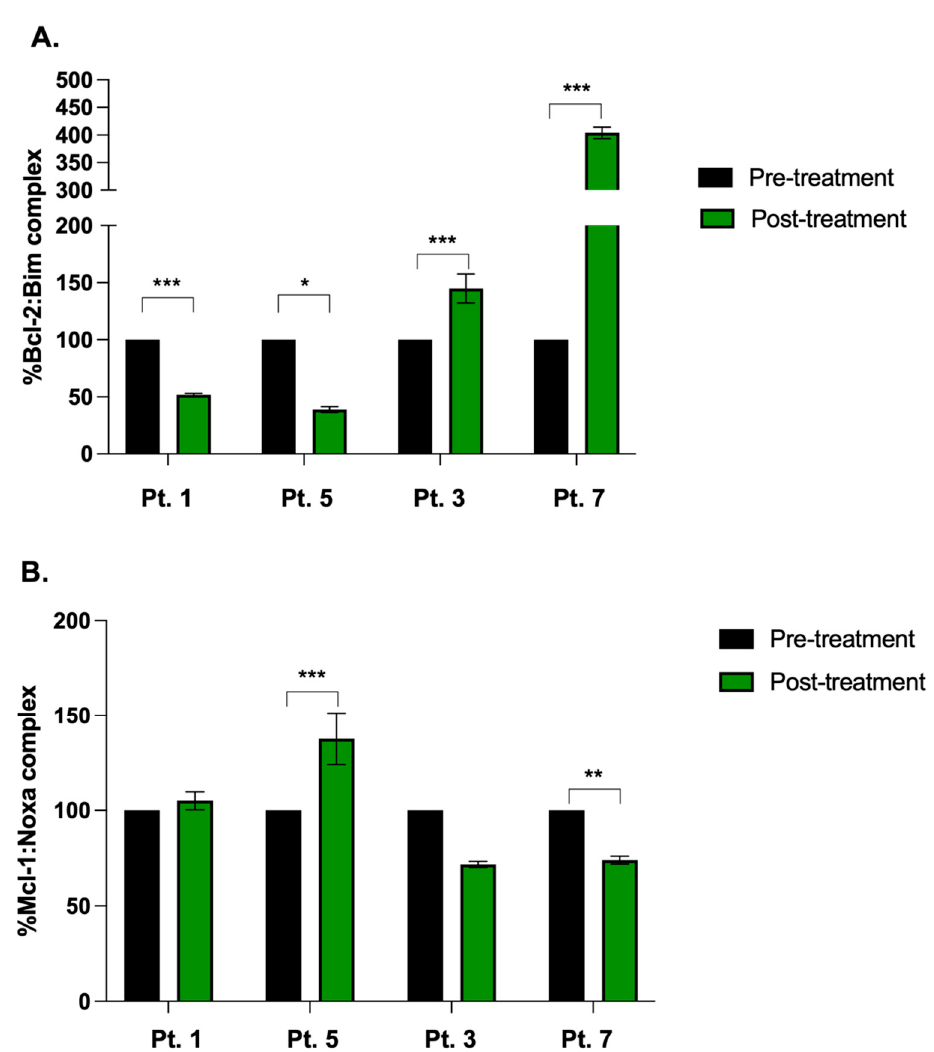
Figure 4. Binding interaction between anti-apoptotic and pro-apoptotic Bcl-2 family proteins in patients on ARd treatment. MSD-ELISA was performed on MM tumor cells isolated from 4 MM patients at baseline (pre-treatment) and after 2 cycles of ARd (post-treatment) showing ( A ) % of Bcl-2:Bim complex formation or ( B ) % of Mcl-1:Noxa complex formation. Data shown are mean ± standard error of the mean (* p < 0.05; ** p < 0.001, *** p < 0.001).